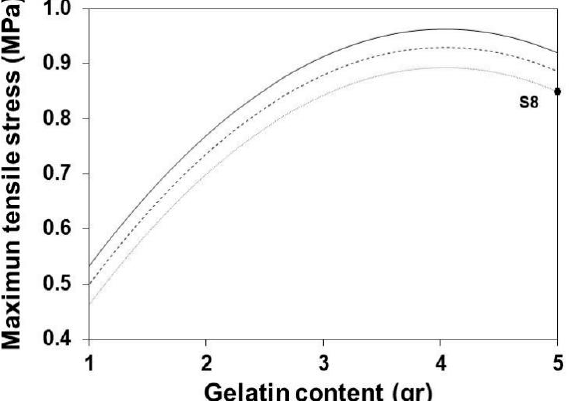
Figure 6. Effect of gelatin on the MTS of SLGMs, varying formation time 1.0 min (continuous), 7.5 min (dashed) and 15.0 min (dotted). Experimental point: S8. Conditions: water content = 50 mL; plasticizer content = 1.0 mL.